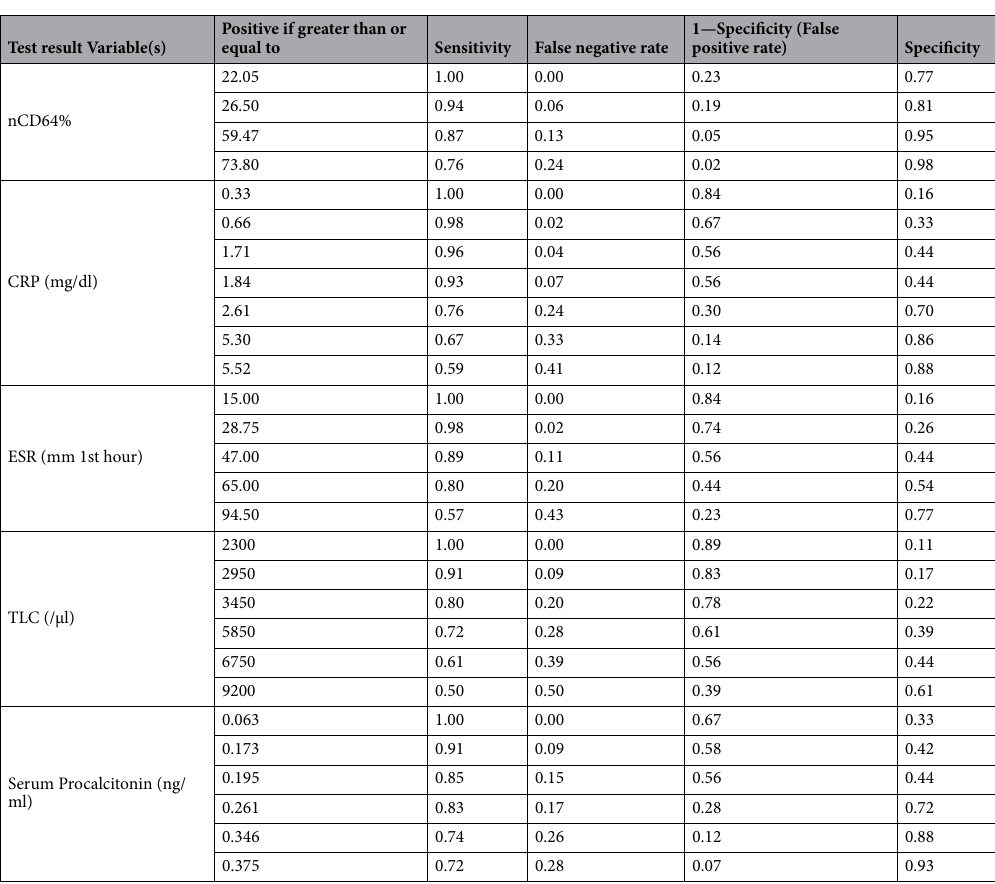
Table 4. Cut off values of the Inflammatory variables using ROC Curve (N = 128). When Values are increasing, chances of the infections are also increasing i. e. Higher values Indicate more positive